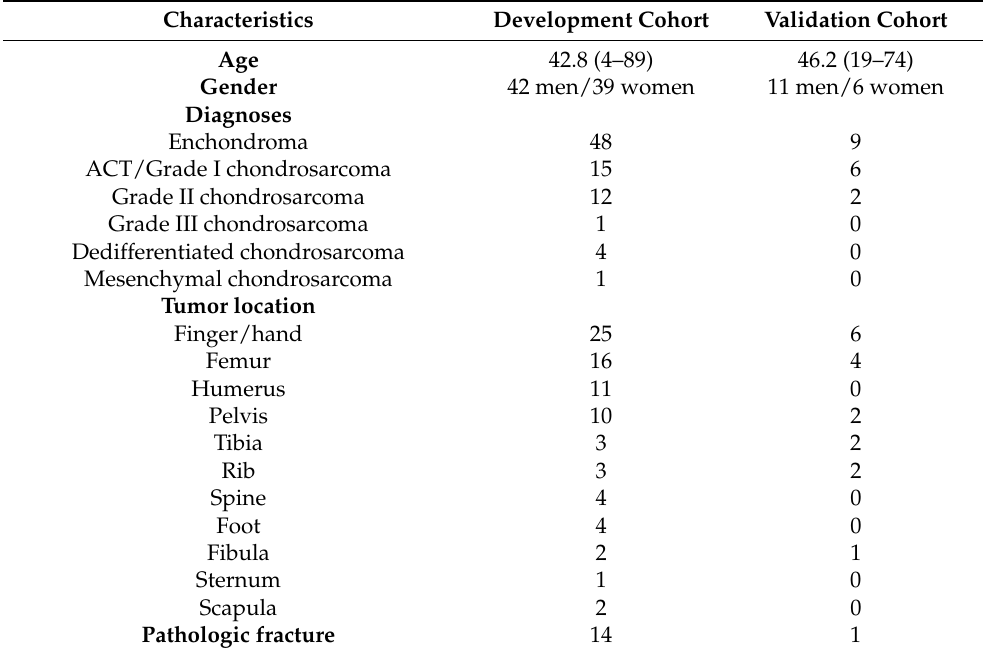
Table 1. Characteristics of study